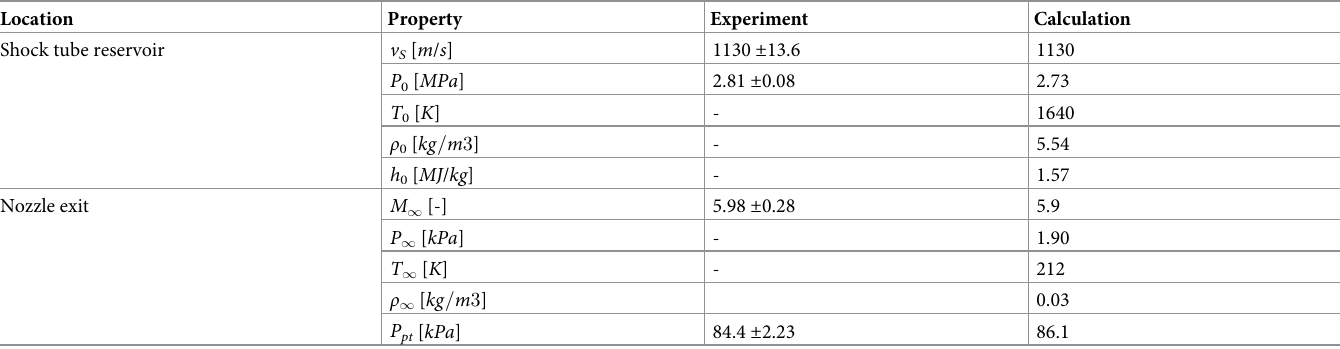
Table 1. Test flow condition for drag